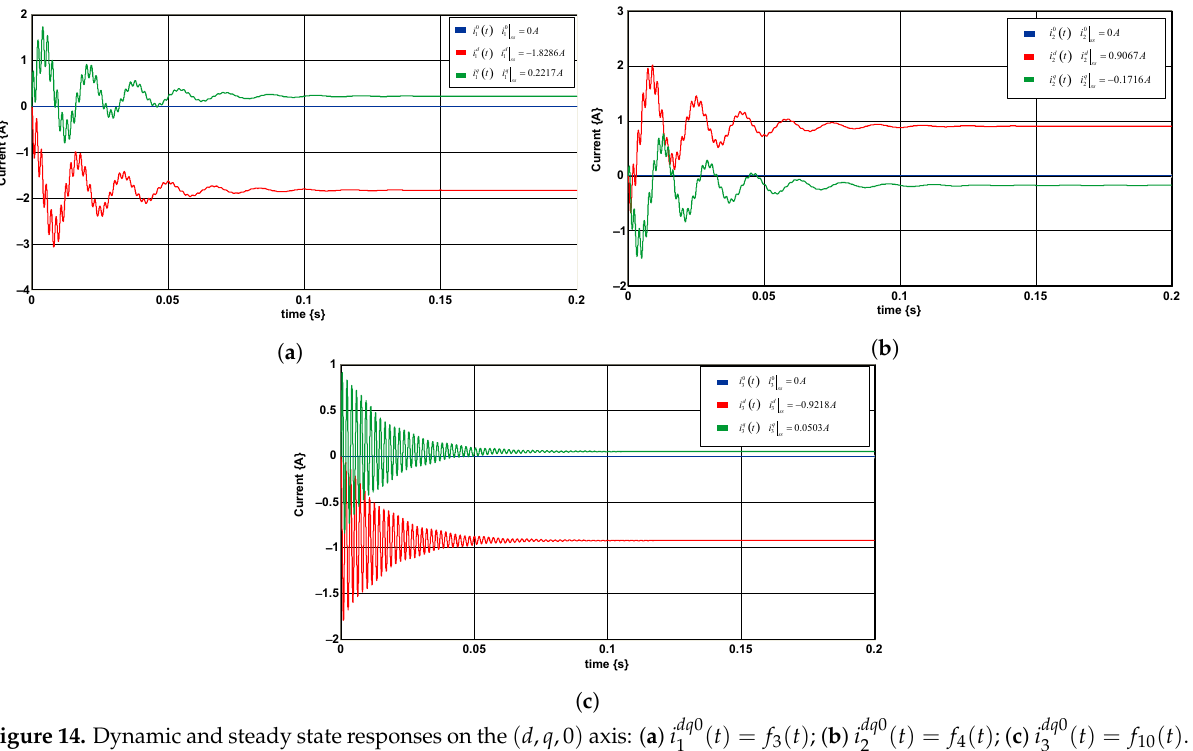
Figure 14. Dynamic and steady state responses on the ( d , q ,0 ) axis: ( a ) i dq 0